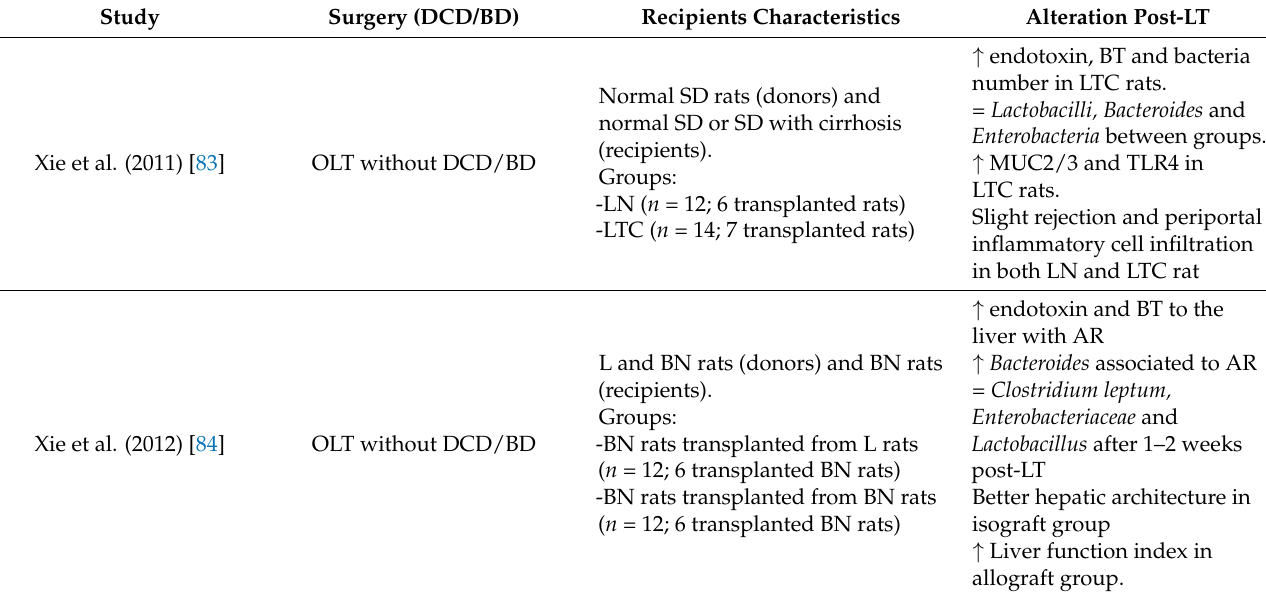
Table 1. Preclinical studies in liver transplantation